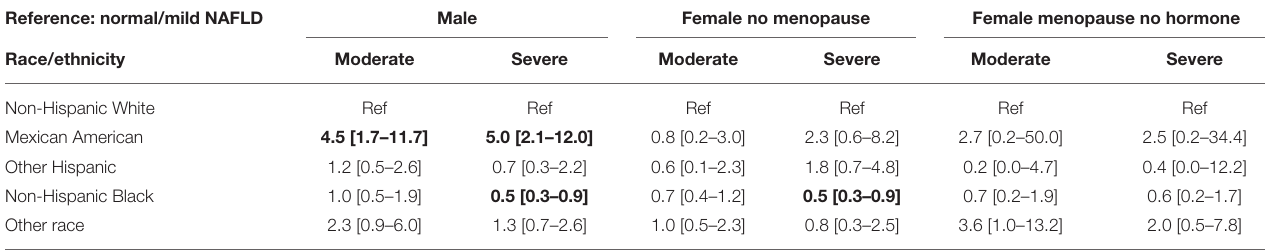
TABLE 7 | Adjusted odds ratio (AOR) and 95% confidence interval (CI) of the association between NAFLD stage and race/ethnicity for each gender group. Reference: normal/mild